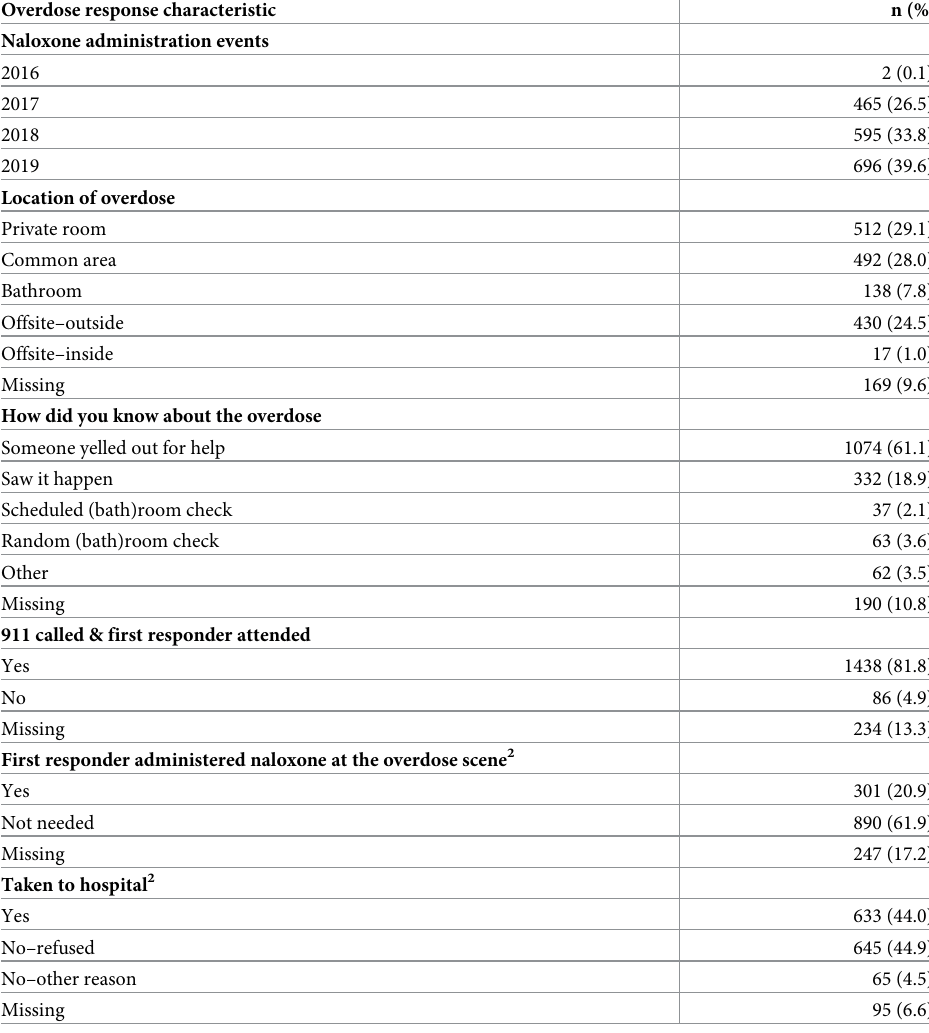
Table 2. Characteristics of overdose reported through naloxone administration forms (n = 1,758) 1